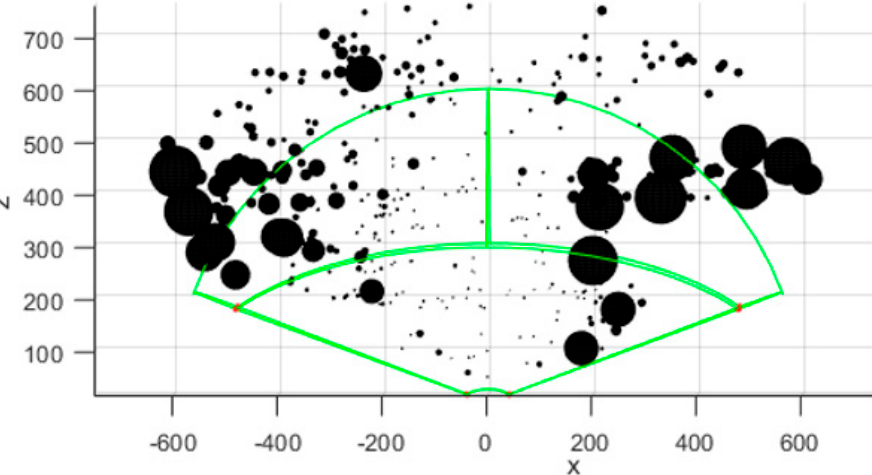
Figure 11. Up to 80 cm: front–back view. X and z axis are in mm.